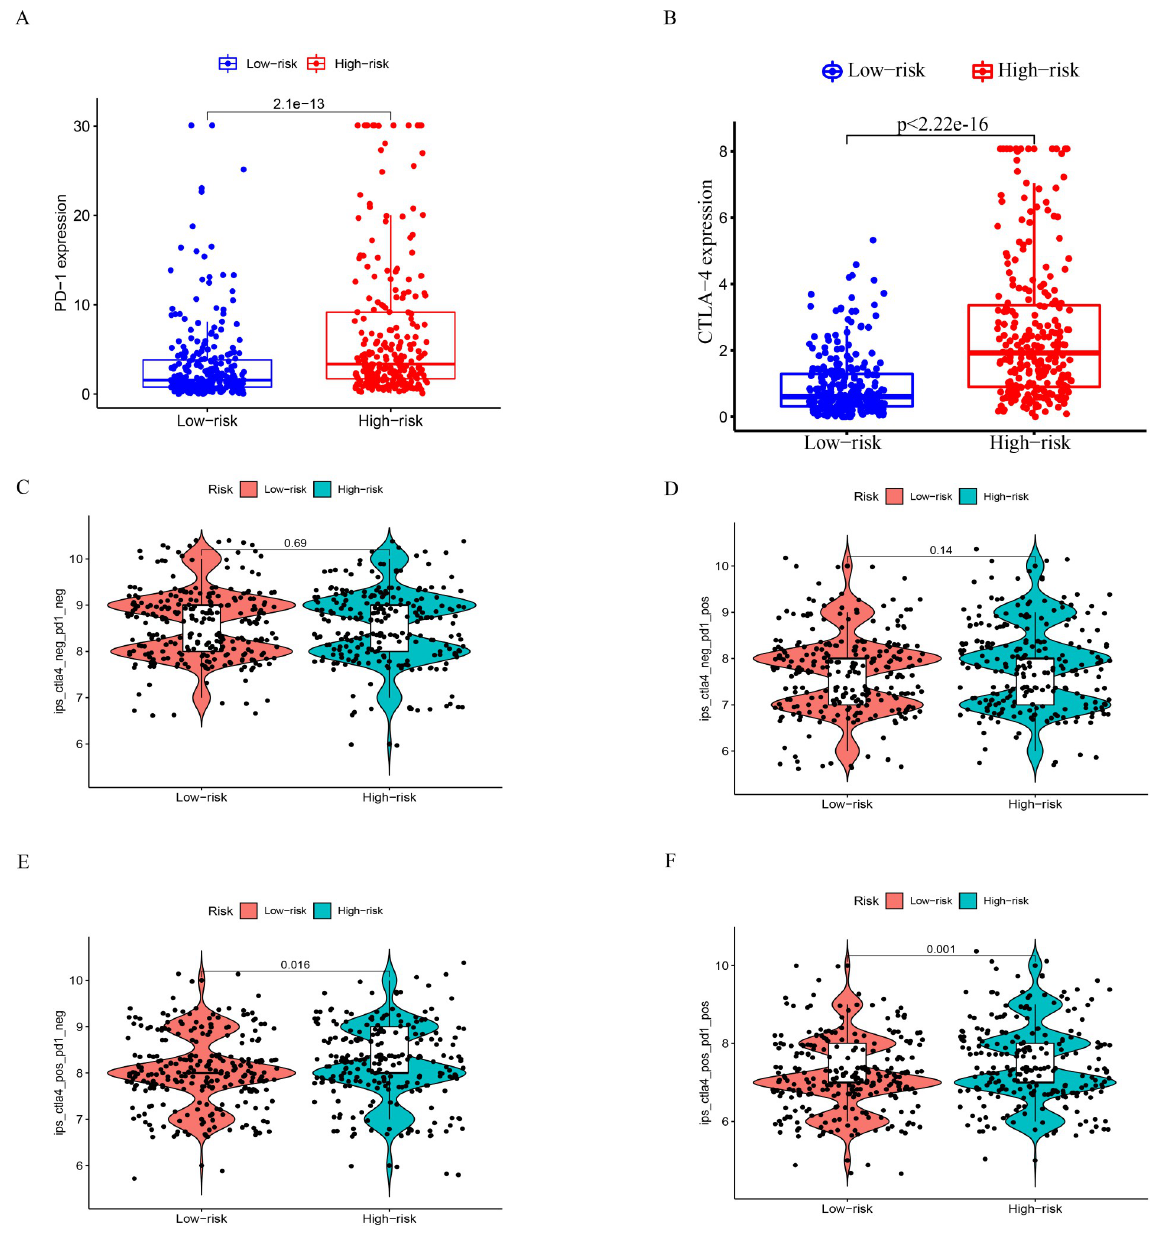
Fig 7. Differential expression of PD-1 and CTLA-4 and related immunotherapy in patients in the two risk groups. (A-B) represents the differential expression of PD-1 and CTLA-4 in the two risk groups. (C–F) represents the difference analysis of patients in the two risk groups when receiving immunotherapy for anti-PD-1 and